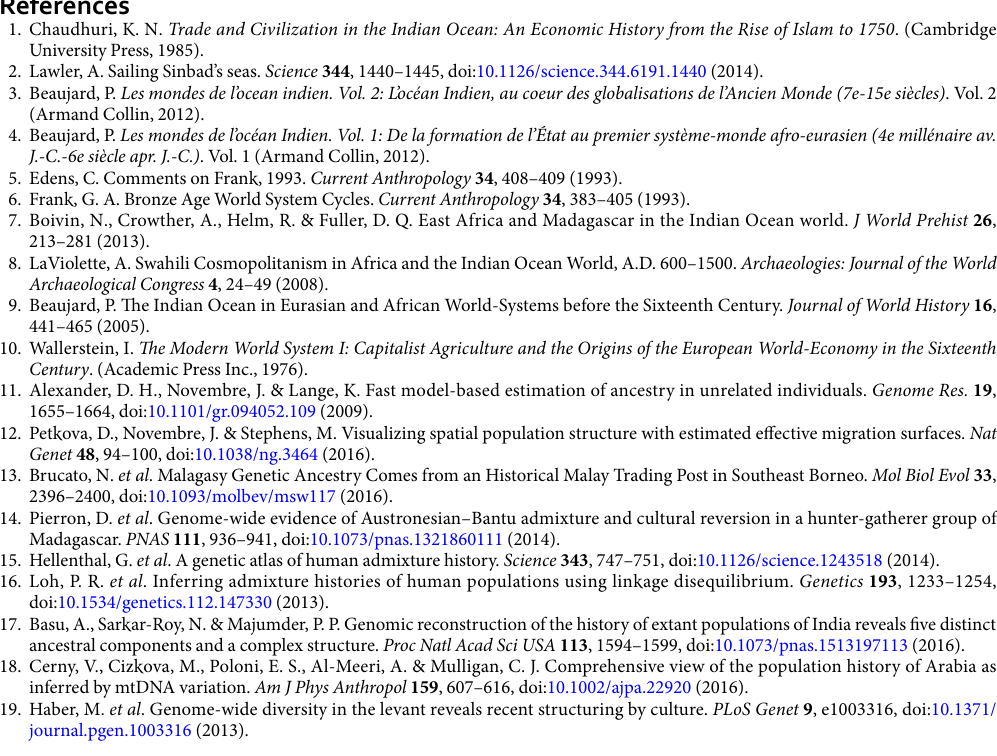
(Supplementary Table 7). After all criteria were applied, 22 clusters were defined (Supplementary Table 1 and Supplementary Figure 4). To test different scenarios of admixture we performed GLOBETROTTER v2.0 15 analyses for each population (excluding outliers) defining surrogates populations from all clusters but its own. Note that the numbers of popu- lations within a given cluster is not correlated with the estimated dates of admixture ( P = 0.95). The painted chro- mosomes obtained by CHROMOPAINTER v2.0 31 for each population were used in GLOBETROTTER v2.0 15 to estimate the ratios and dates of the potential admixture events that characterize them. Coancestry curves were estimated with and without standardization using a ‘NULL’ individual, and consistency for each estimated param- eter was checked. 100 bootstrap resamplings were performed to estimate the p-value of the admixture events (considering the ‘NULL’ individual) and the 95% confidence interval for the obtained dates. The ‘best-guess’ scenario given by GLOBETROTTER v2.0 15 was considered for each target population. Admixture events whose estimated 95% confidence intervals of dates between both ‘NULL0’ and’NULL1’ models do not overlap were subsequently reclassified as ‘uncertain’, as described by Hellenthal et al . 15 . To obtain a second estimate of potential admixture scenarios, we ran MALDER v1 16 , a modified version of the ALDER v1.3 16 software to observe any mul- tiple admixture events, using the parental populations defined by GLOBETROTTER v2.0 15 . Both analyses give highly correlated admixture dates (r 2 = 0.65; P < 0.00001; Supplementary Figure 7). The estimated dates likely reflect the midpoint or end of noticeable admixture events rather than the exact date of migration (which could occur prior to any admixture). The number of migrations per century is equivalent to the cumulative number of parental populations, given by the ‘best-matching’ scenario in GLOBETROTTER v2.0 15 , and involved in each admixture event not defined as ‘uncertain’ (Supplementary Tables 3 and 4). Dates of admixture, given in genera- tions, were converted to chronological time using a generation interval of 25 years. In parallel with the admixture dates obtained from GLOBETROTTER 15 and MALDER 16 , we computed geo- graphical distances and historical trading volumes in order to perform correlation tests. Euclidian distances between a given target group, whose admixture scenario is not defined as ‘uncertain’ in GLOBETROTTER v2.0 15 , and each of its parental sources, given by the ‘best-matching’ scenario, were calculated using the great circle for- mula. We used the estimated value of 6,371 km for the Earth’s radius. Average volumes of trade per century were calculated from historical data 9 . Five measures of trade volume were taken for each century to obtain an average per century. This allows us to compare these data to the number of admixture events per century. However we note that this also smoothes the exact evolution of trade, as more precisely described in Beaujard 9 , as for exam- ple the drastic decrease observed at the end of Phase III 9 which appears more progressive in our representation (Fig. 1). Therefore this measure does not reflect the exact evolution of trade volume but rather its overall trend across the centuries. Descriptive statistics of the distance of gene flow per century, correlation tests, t-tests and analyses of variance were computed with SPSS v20.0 38 . Curves were generated in SPSS v20.0 38 using the spline interpolation. We performed correlation tests between our variables as we did not put any assumption on the dependence of one to another (for example, trade on the number of migrations). We performed an F-test to compare the models with time and volume of trade using SPSS v20.0 38 . When required, the Bonferroni multiple testing correction was applied. Networks were generated with Cytoscape v3.2.1 39 and maps were generated using Global Mapper v.15.